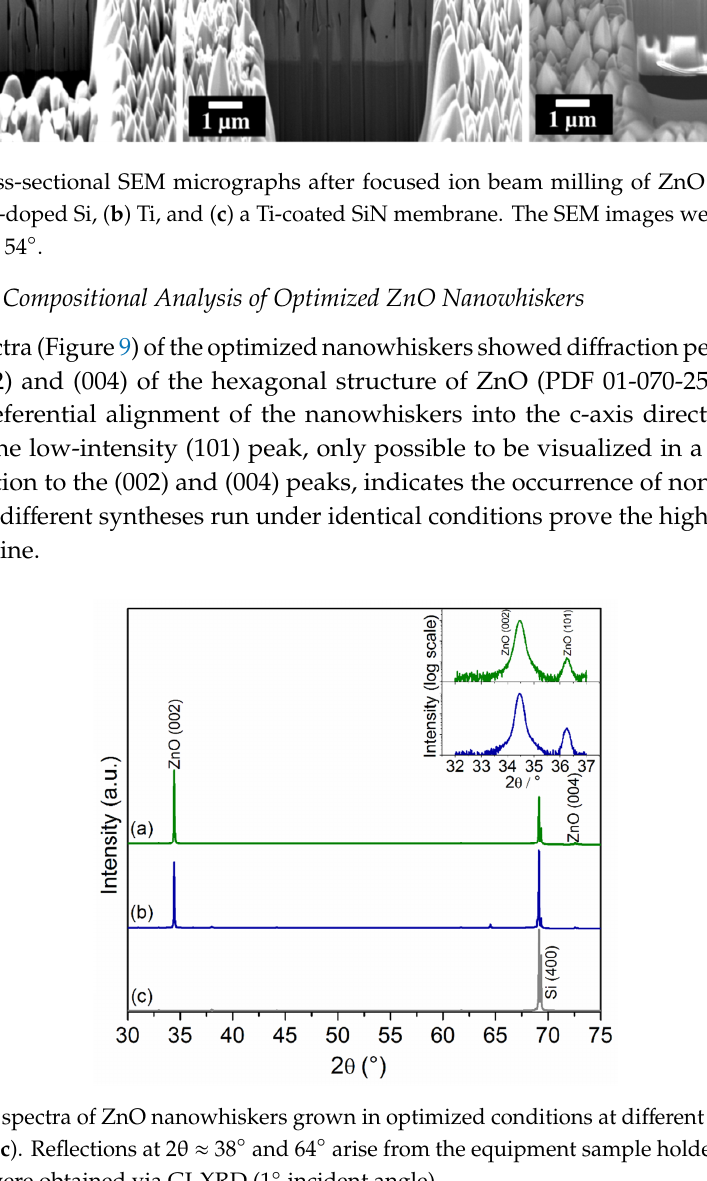
Figure 10. EDX line scan of a ZnO nanowhisker at the substrate edge grown in optimized conditions. The intensity profile reveals a constant ratio of Zn and O in 1:1 stoichiometry along the nanowhiskers axis. The aluminum originates from the sample holder. 4. Field Emission Measurements Characteristic field emission—the non-linear increase of emission current—is observed for n- doped Si, Ti film on Si, and a Ti-coated 1.5 µm-thick freestanding SiN membrane upon increasing the applied electrical field (Figure 11a). In detail, the turn-on field—here defined as the applied electric field necessary for the emission current to overcome a 5σ threshold from the data mean—is found to be lower for ZnO nanowhiskers grown on n-doped Si than for nanowhiskers grown on Ti films. Note, the local electric field at the tip of an emitter can be in orders of magnitudes higher than the externally